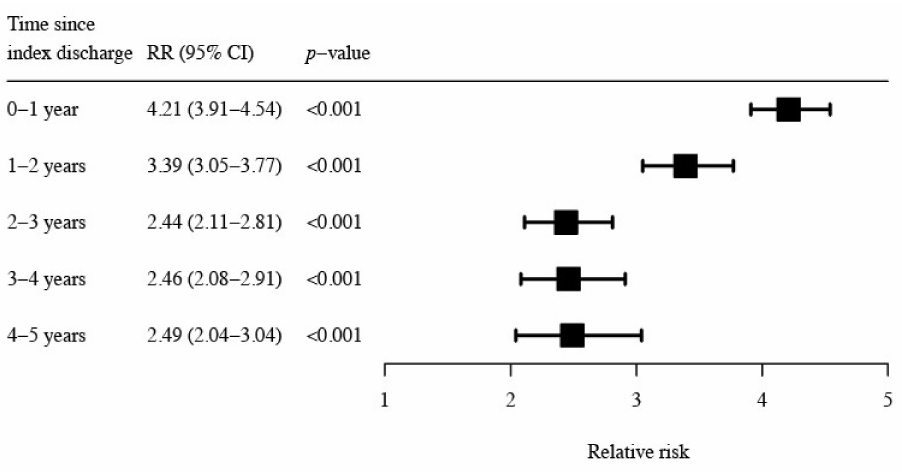
Figure 1. Probability of post-index ADR-related admission for patients with ADR compared to non-ADR-related index admissions.